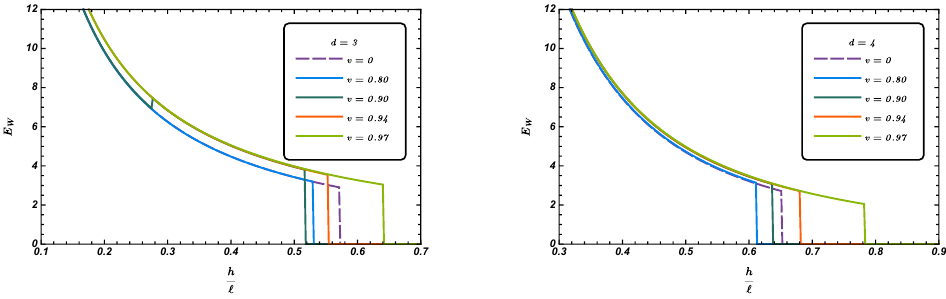
Figure 3 . EoP for d = 3 (left) and d = 4 (right) as functions of the width and separation between subregions with r h = 1 for different values of v